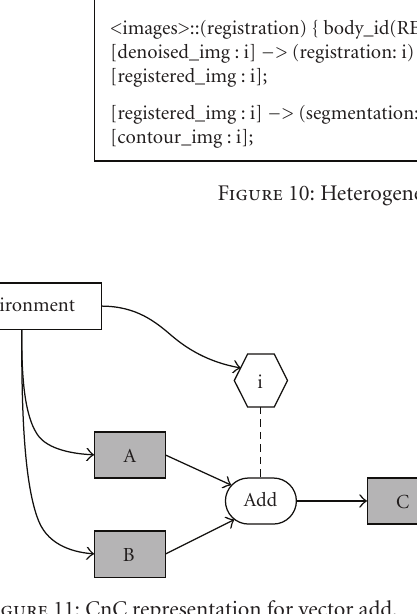
Figure 11: CnC representation for vector add.